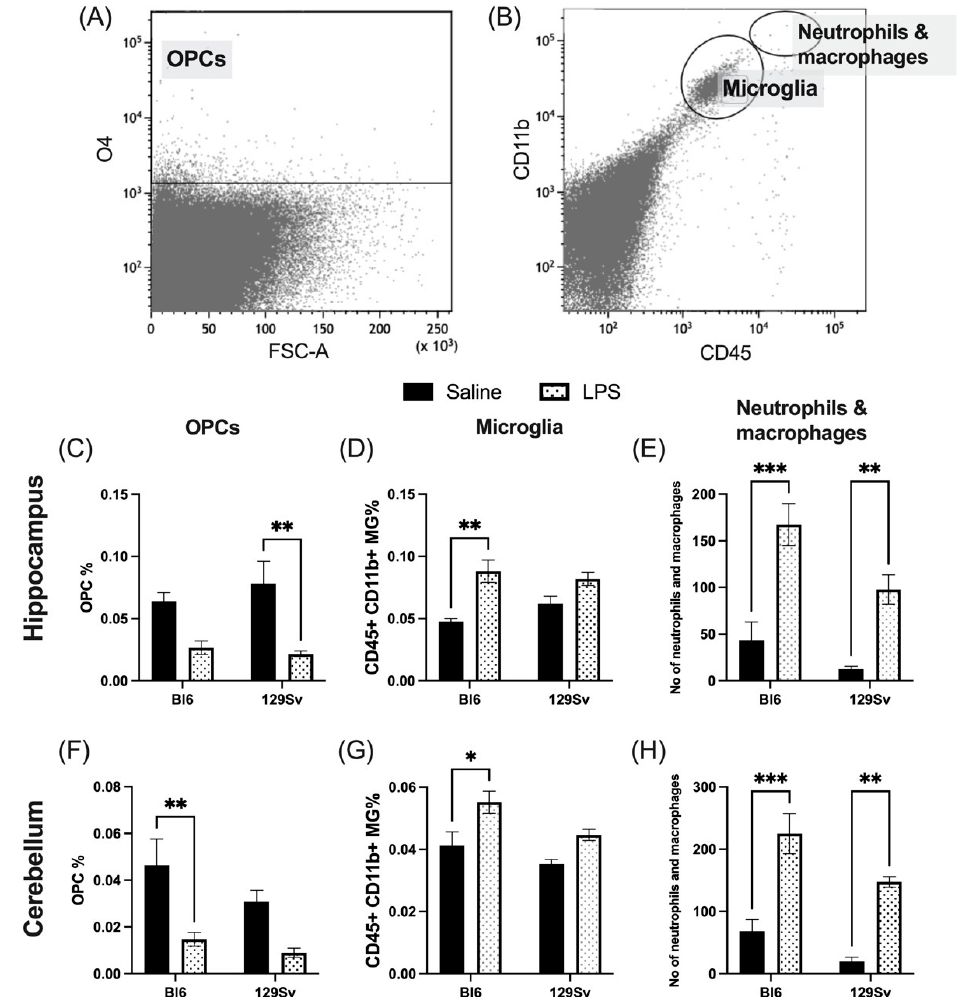
Figure 4. LPS-induced alterations in cell abundance of oligodendrocyte progenitor cells (OPCs), microglia, and neutrophils and macrophages within the brains of Bl6 and 129Sv mice. A representative gating strategy for ( A ) O4 positive OPC population, ( B ) CD11b+ CD45 intermediate microglia population, and CD11b+ CD45 high neutrophil and macrophage population. ( C ) Percentage of OPCs, ( D ) microglial cells, and ( E ) number of neutrophils and macrophages in hippocampus. ( F ) Percentage of OPCs, ( G ) microglial cells, and ( H ) number of neutrophils and macrophages in cerebellum. Data are expressed as mean values ± SEM. Data was analyzed by two-way ANOVA followed by the Bonferroni post hoc test: * p ≤ 0.05, ** p ≤ 0.01, *** p ≤ 0.001.